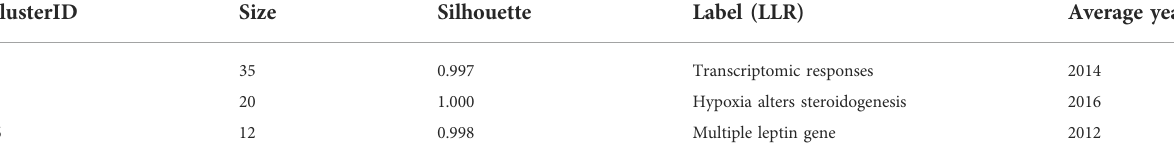
TABLE 10 Three (3) major clusters that emerged from the article co-citation analysis for research on medaka and climate change. ClusterID Size